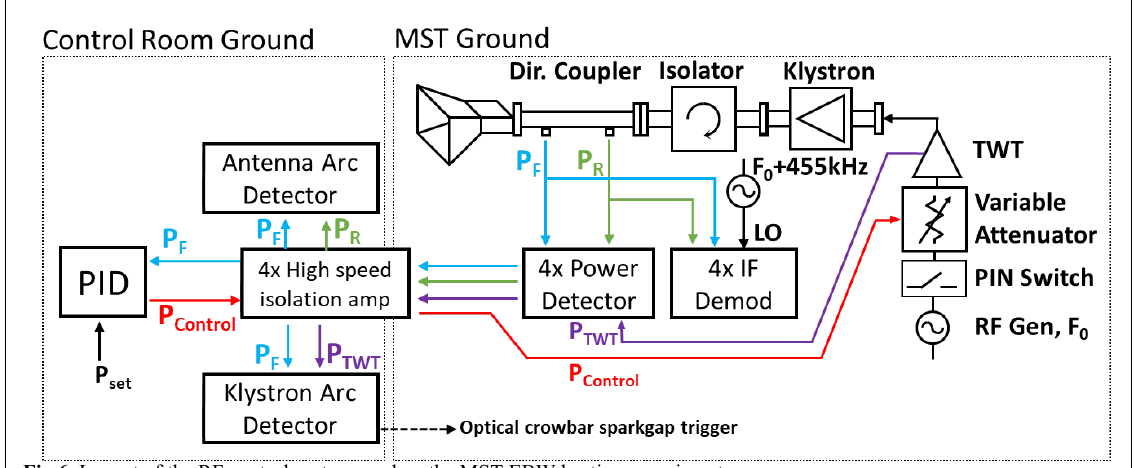
Fig 6. Layout of the RF control system used on the MST EBW heating